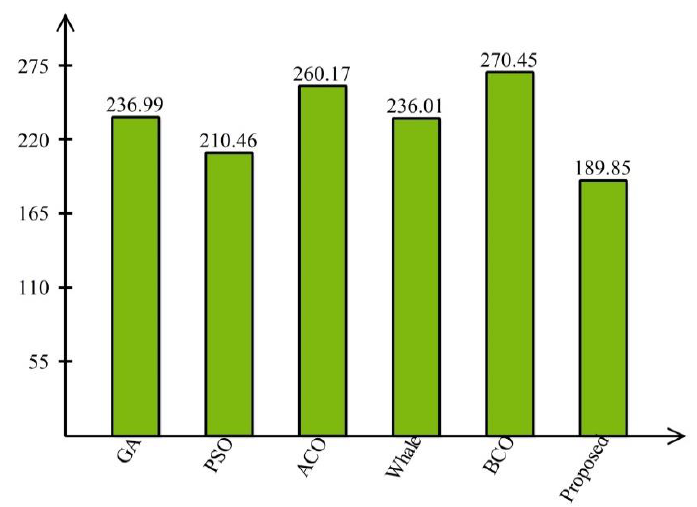
Figure 15. Time comparison for the real-time dataset.